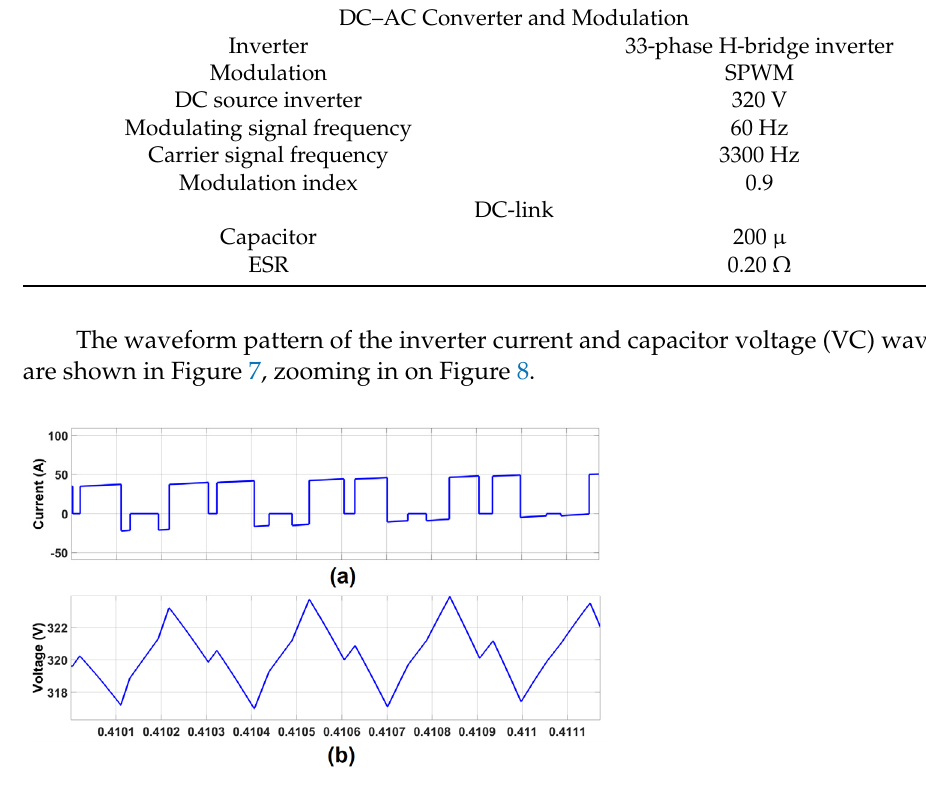
Figure 7. Capacitor voltage waveform pattern ( a ); inverter current ( b ) in the critical case.